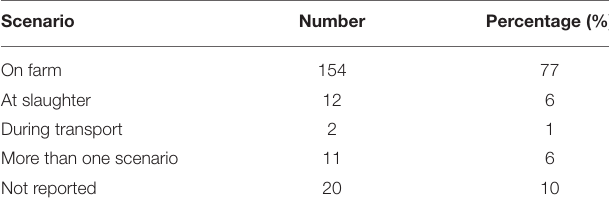
TABLE 3 | Number and percentage of papers including a general animal-based measures codified term according to the different scenarios.